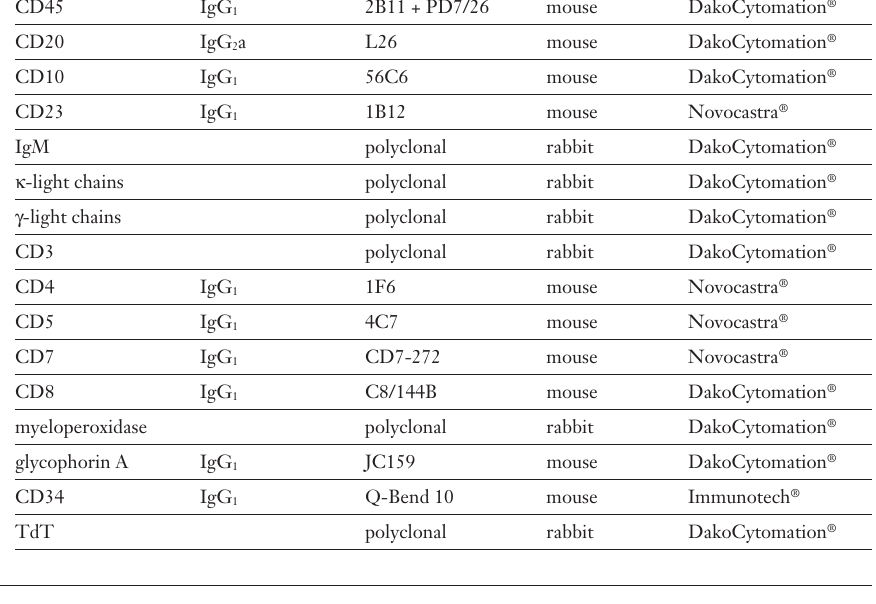
Specifications of antibodies used for immunophenotyping with flow cytometry (FITC = fluorescein isothiocyanate, PE =